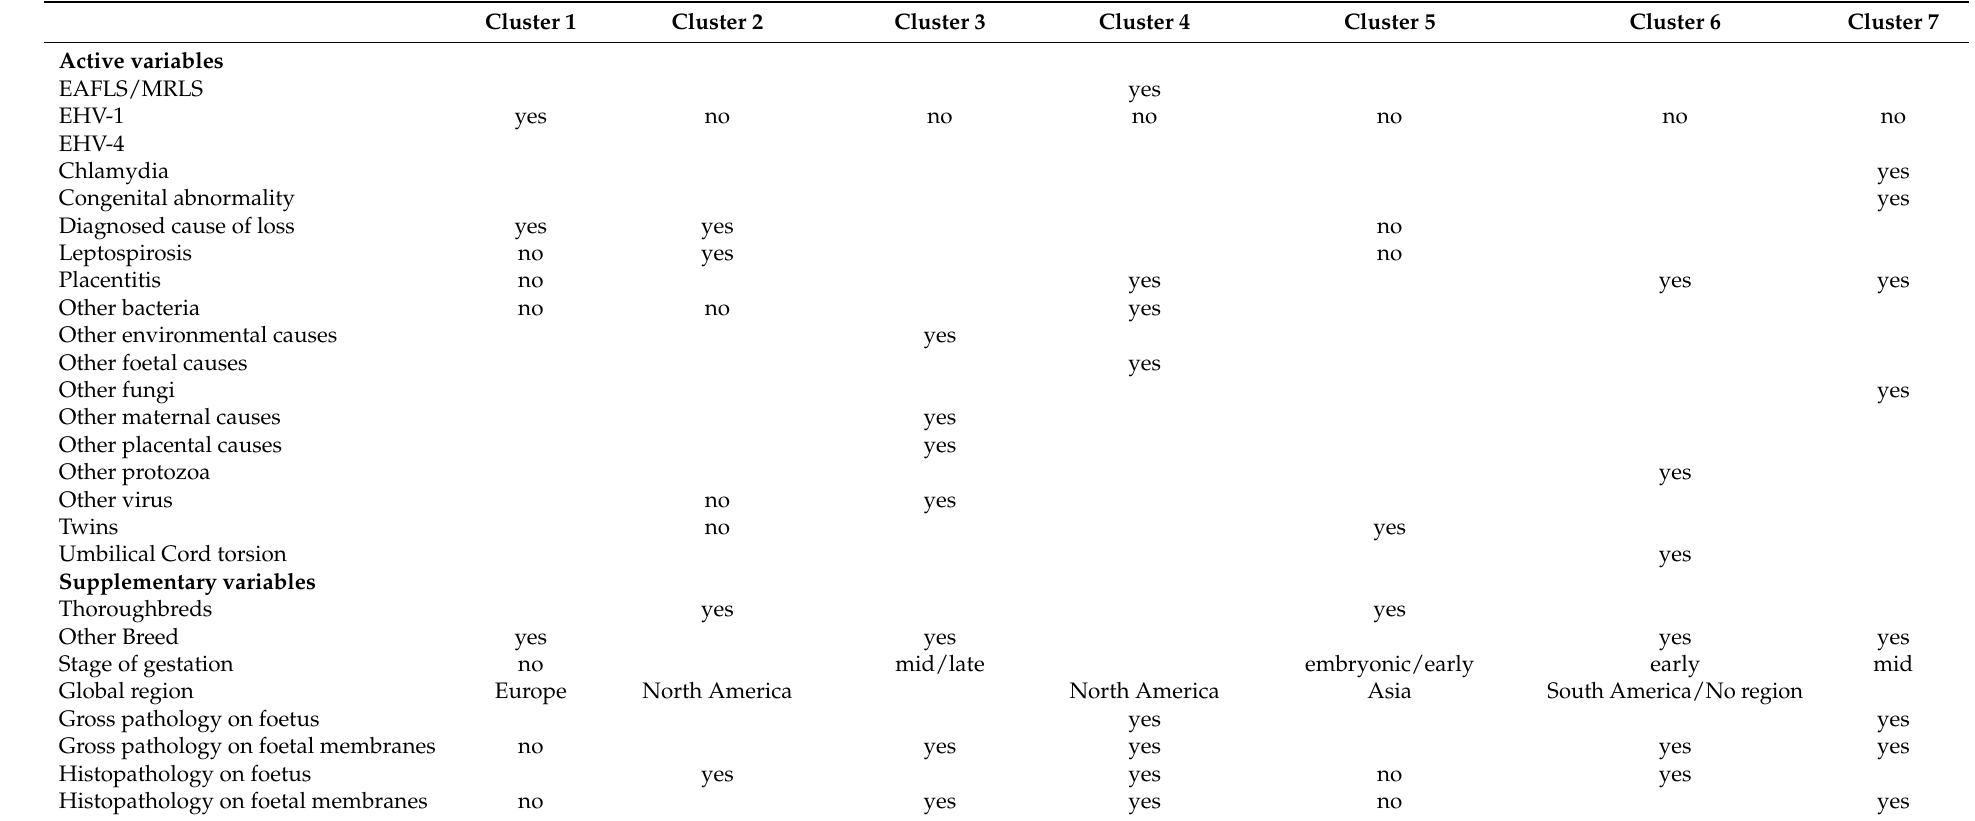
Table 1. The active and supplementary variables contributing to the formation of the clusters from the MCA of data extracted from 514 studies captured in a scoping review of the reported causes and syndromes associated with mid to late-term pregnancy loss in horses